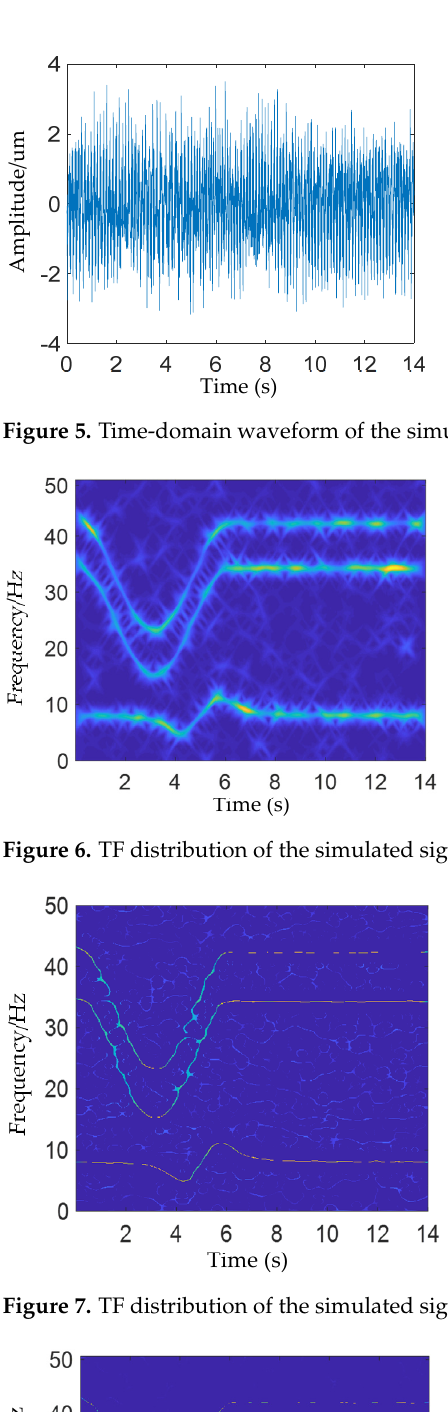
Figure 4. TF distribution of the simulated signal based on RSECT.